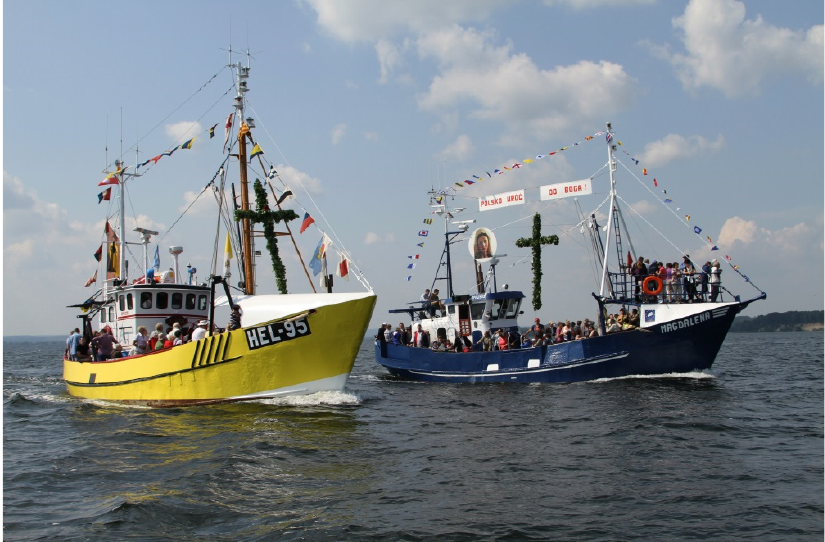
Figure 3. Hel-95 and Magdalena fishing boats. Author: (Tadeusz Palmowski 2013).